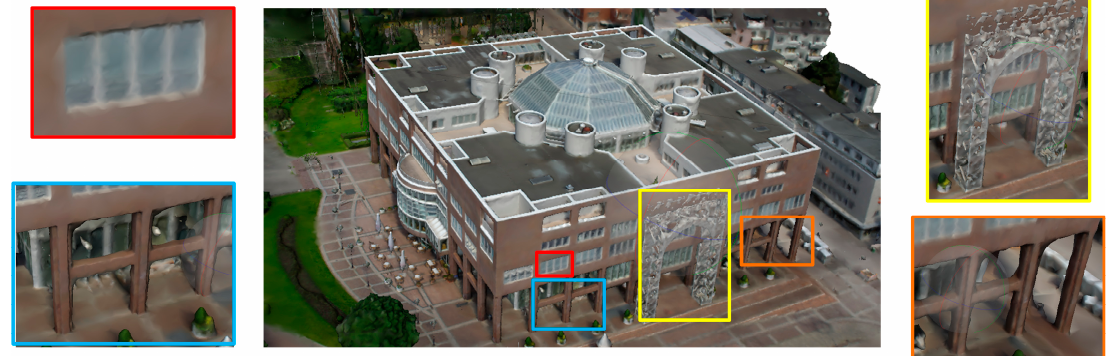
Figure 17. The model generated after the aerial–terrestrial images were aligned by SuperGlue.